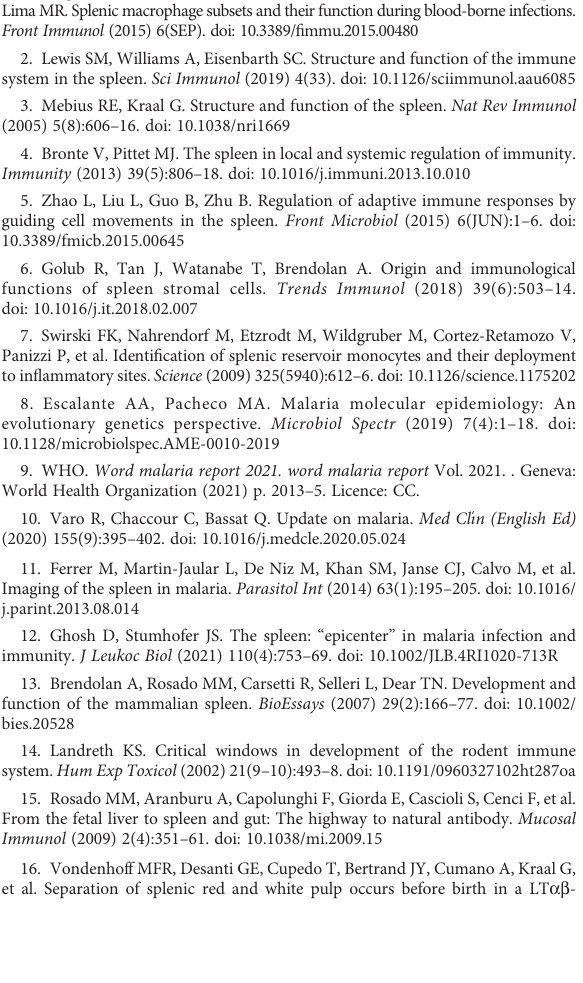
SUPPLEMENTARY VIDEO 3 3D video of the spleen from a 1-week mouse. Media shows vasculature (anti-CD31, in blue), macrophages (anti F4-80, in green), monocytes (anti-Ly6C, in red), neutrophils (anti-Ly6G, in yellow), B lymphocytes orange) and T lymphocytes (anti-CD3e, in